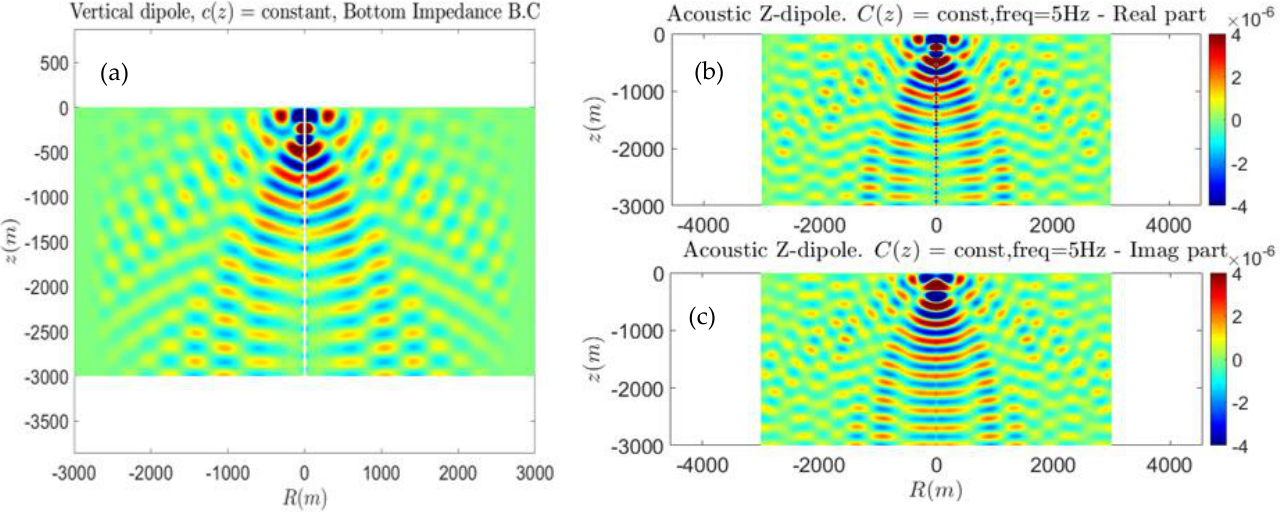
Figure 17. ( a ) The acoustic field obtained using the solution of the FDTD–PML numerical scheme excited by a vertical dipole source of frequency f = 5 Hz located at a depth of 300 m with an impedance bottom boundary condition in an isovelocity environment. ( b , c ) Real and imaginary parts of the acoustic field obtained using the solution of the Helmholtz equation excited by a vertical dipole source of frequency f = 5 Hz located at a depth of 300 m with an impedance boundary condition.